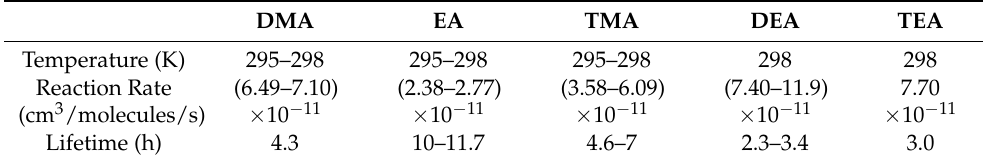
Table 4. Amine reactions with OH; concentration of 1 × 10 6 (molecules/cm 3 ) is assumed in the calculation of species lifetimes. Reaction rates and lifetimes from